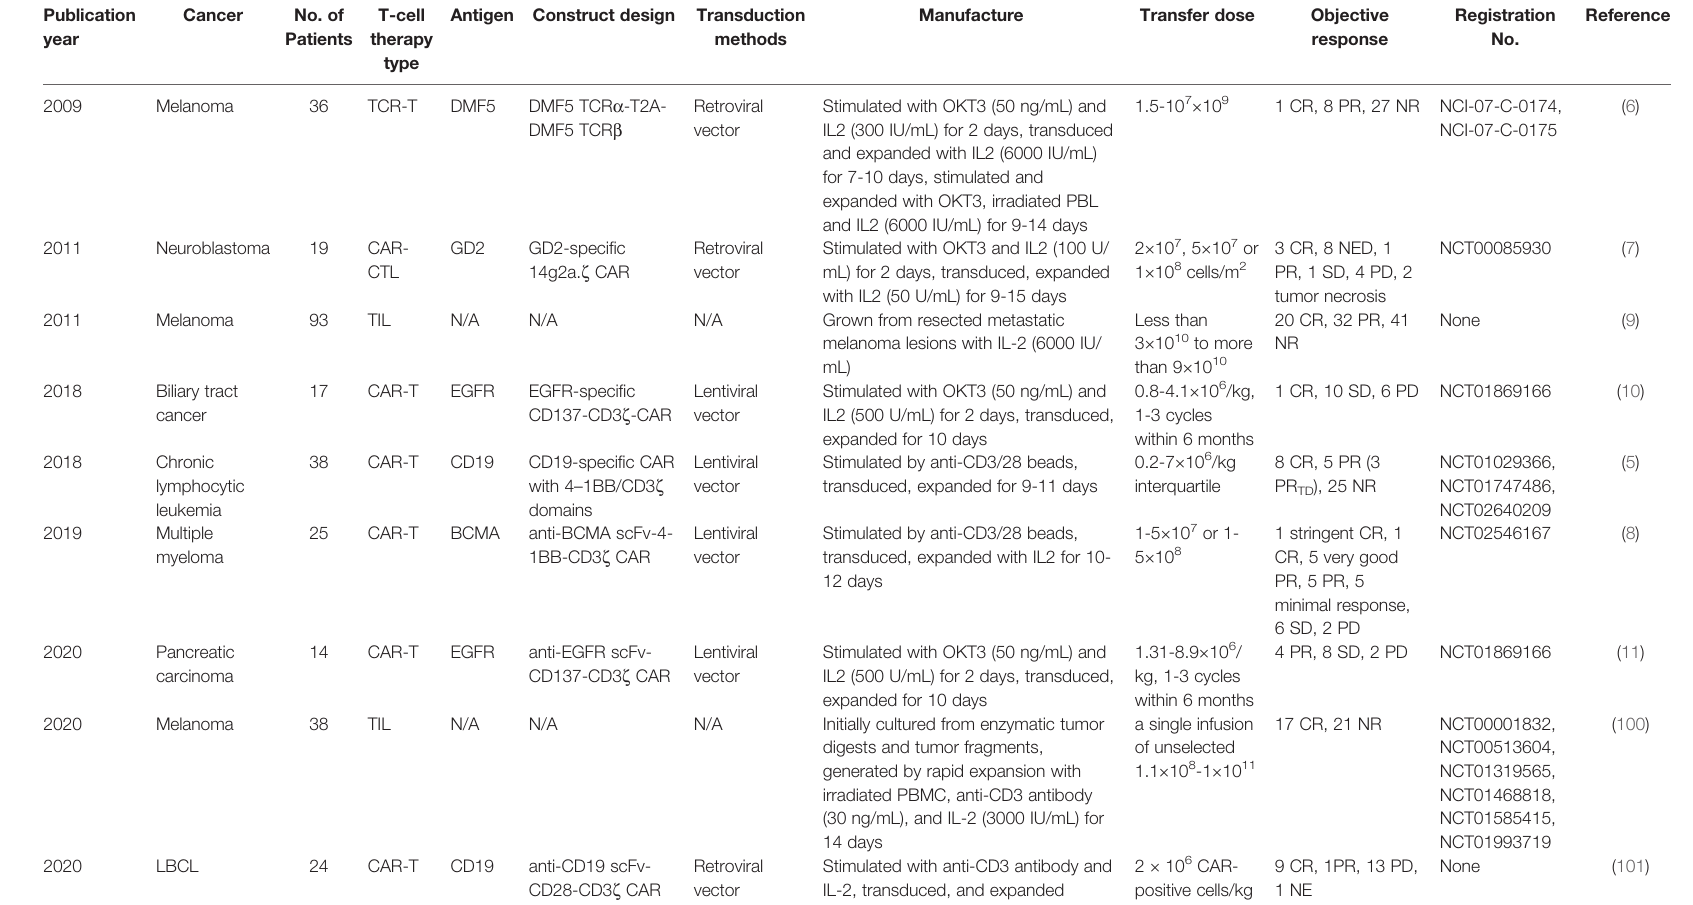
TABLE 2 | Clinical trials on differentiation phenotypes of infused T cells and anti-cancer